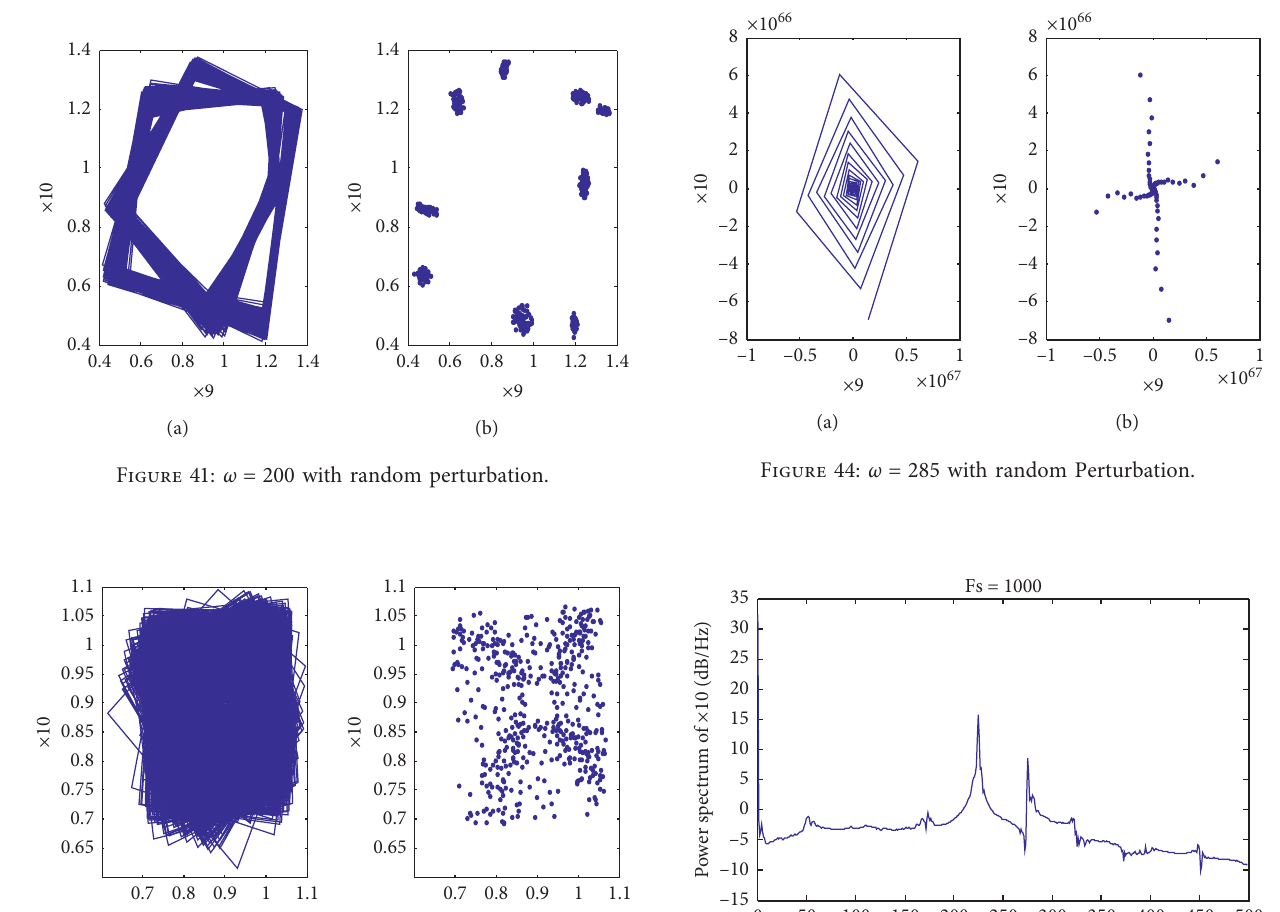
Figure 40: ω � 110 with random perturbation.